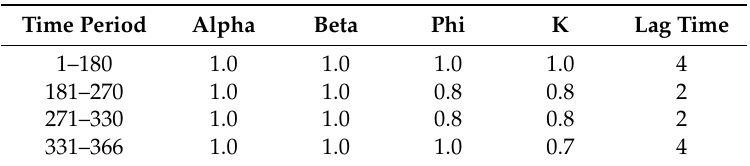
Table 3. Hydroclimatological SWAT calibration parameters for daily stream temperature. Time period is in Julian days and the lag unit is days.